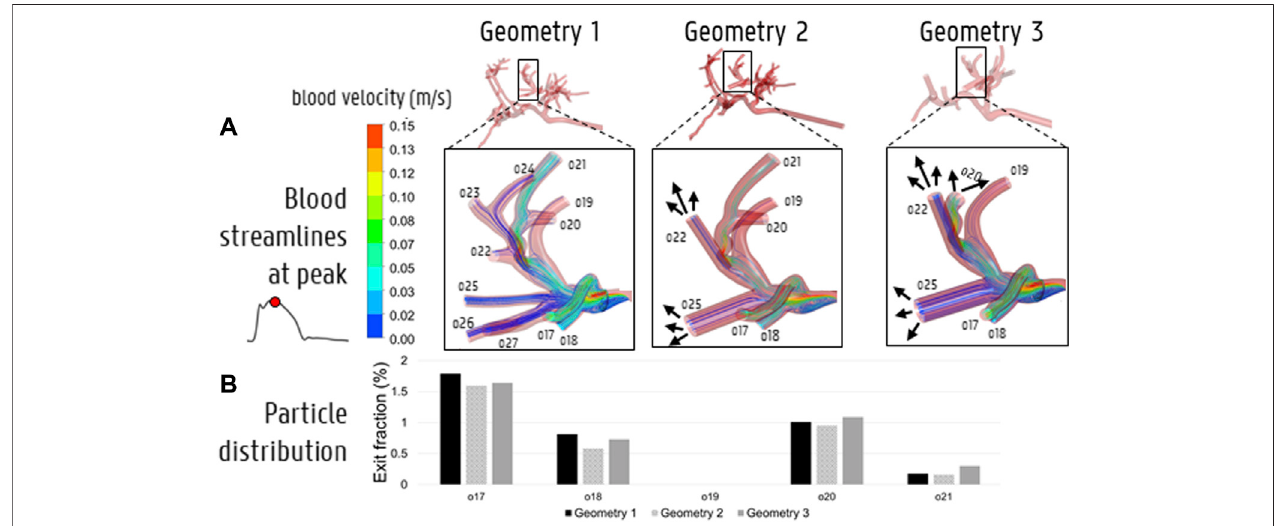
FIGURE 10 | (A) The impact of simplifying the hepatic arterial geometry (Geometry 1 – 2 – 3) on the blood streamlines at peak systole. The arrows indicate where outlets were truncated with respect to Geometry 1, i.e., where the downstream fl ow distribution was used to model the particle distribution beyond the level of this truncated outlet. (B) The impact of truncation on particle distribution in outlets 17 –